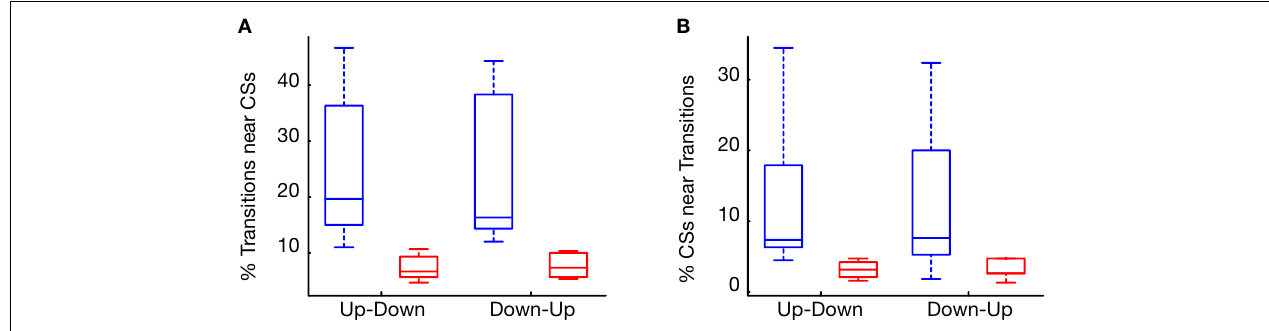
FIGURE 4 | (A) Percentage of transitions near CSs (blue) compared to random (red). (B) Percentage of CSs related to transitions (blue) compared to random